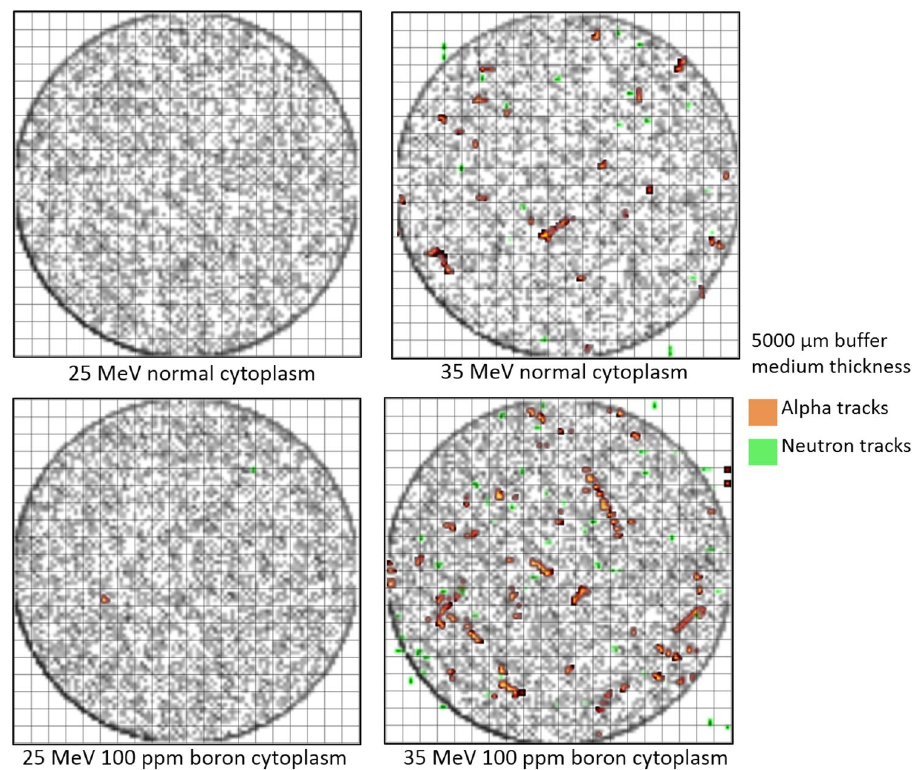
Figure 6. The tracks of alpha particles, neutrons and incident protons (shown in black) generated as a result of 25 and 35 MeV irradiation of cell array with buffer medium thickness of 5000 μm.